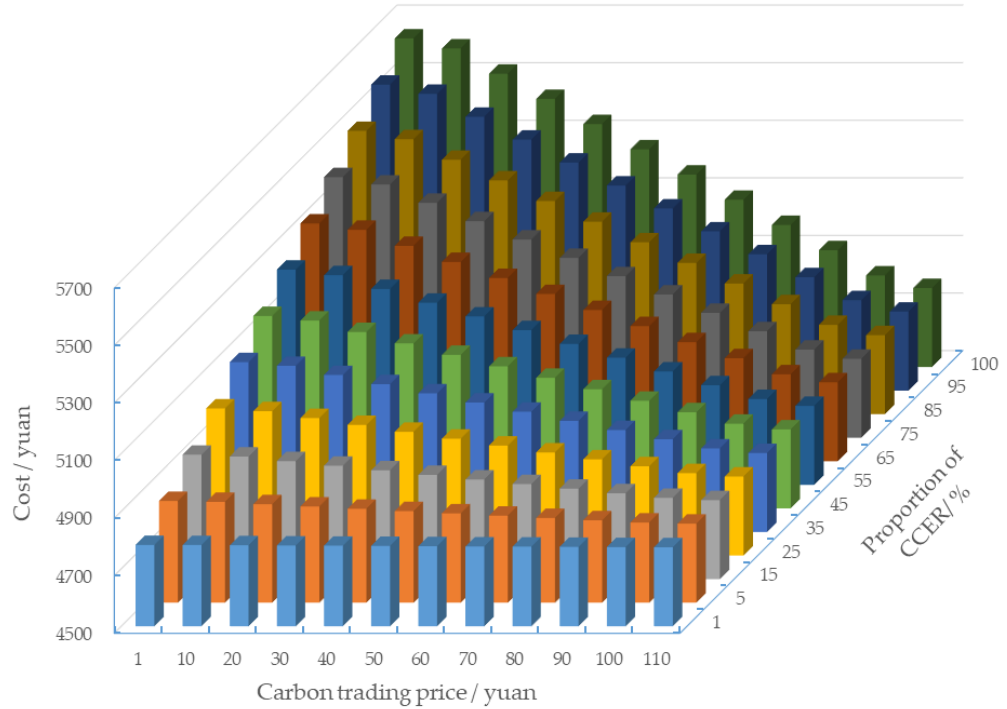
Figure 7. Total system cost under different carbon trading prices and CCER proportion.